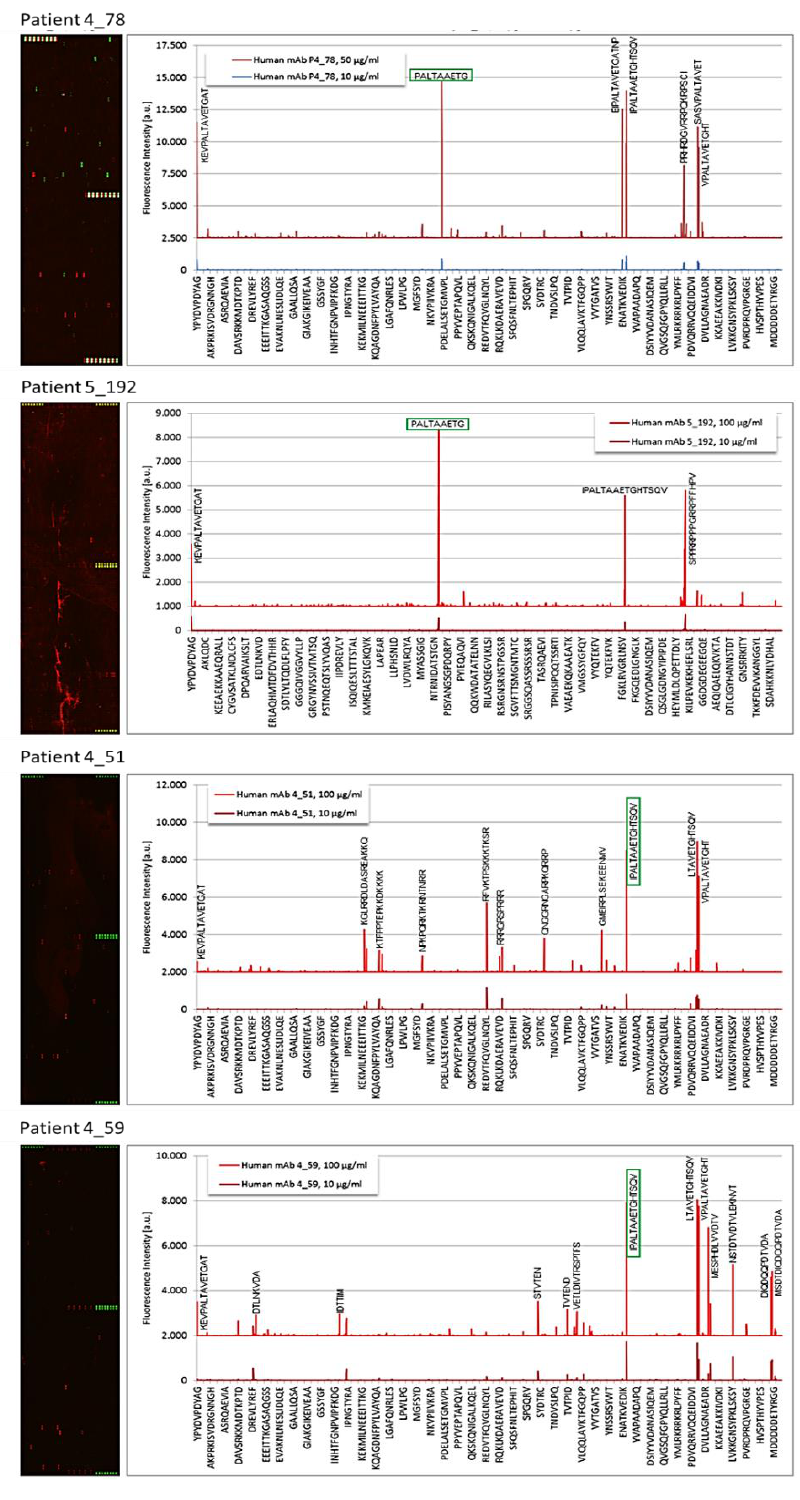
Figure 2. Results of PEPperCHIP ® Infectious Epitope MicroArrays obtained for Monoclonal IgGs Specific for VP1 Coat Protein of Human Coxsackieviruses. Microarrays were incubated with the patient monoclonal IgG (50 or 100µg/mL), stained with secondary and control antibodies, then read out at scanning intensities of 7/7 (red/green) (see Materials and Methods). Antibody response against peptides is annotated next to corresponding signals in intensity plots (left panels). Well-defined staining of HA control peptides appear in green, PV control peptides appear in